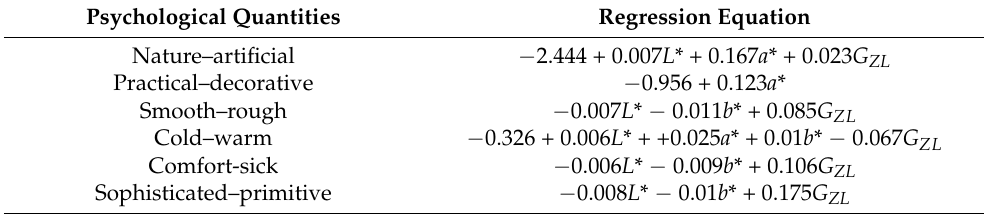
Table 10. Multiple linear regression models for visual psychological quantity